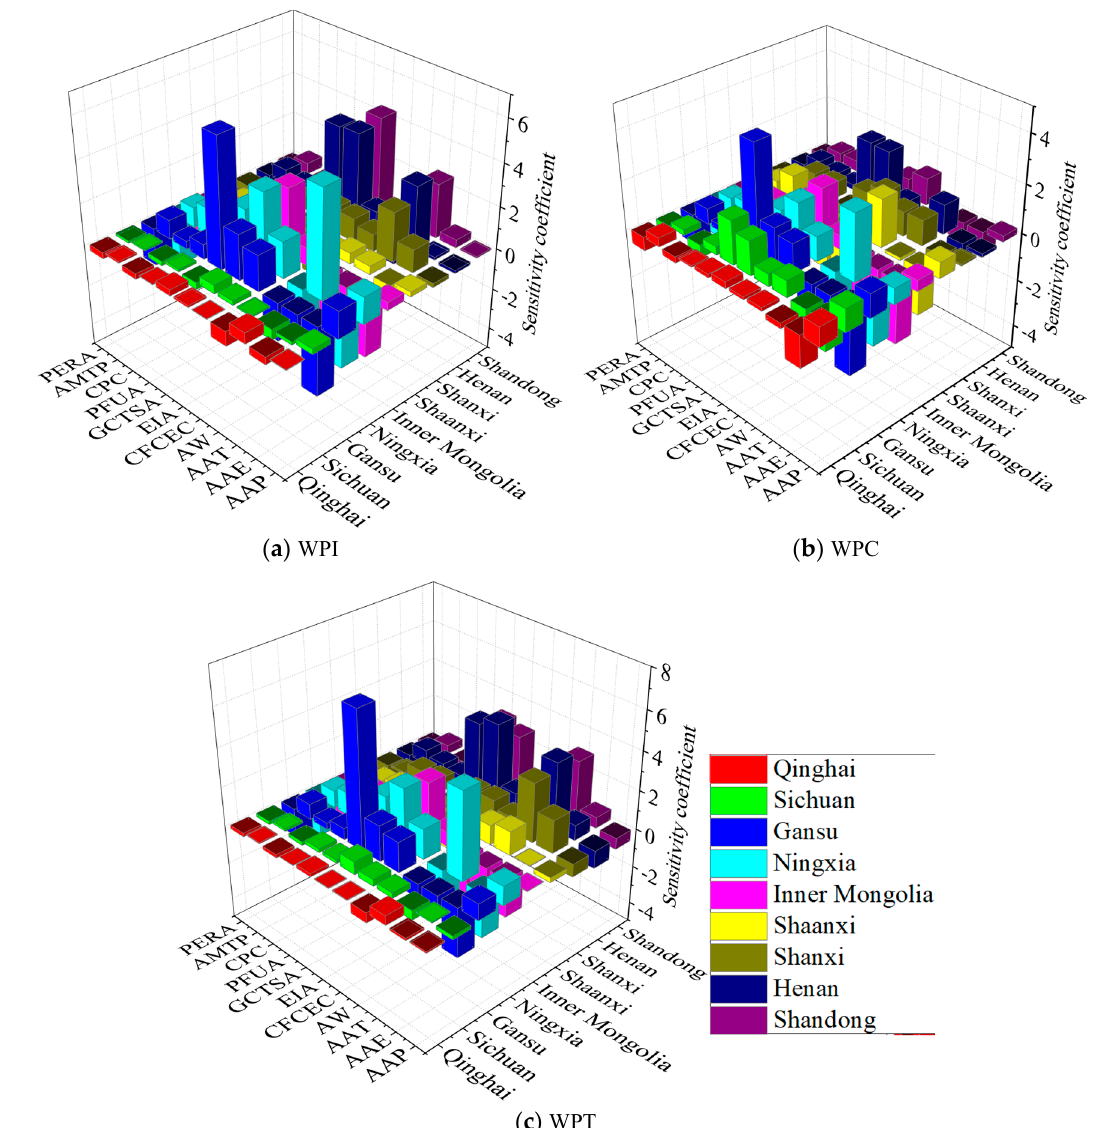
Figure 5. The grey correlation degree of the influencing factors with regard to water productivity. ( a ) Grey correlation degree of the influencing factors to WPI of the provinces (autonomous regions). ( b ) Grey correlation degree of the influencing factors with regard to WPC of the provinces (autono ‐ mous regions). ( c ) Grey correlation degree of the influencing factors with regard to WPT of the provinces (autonomous regions).